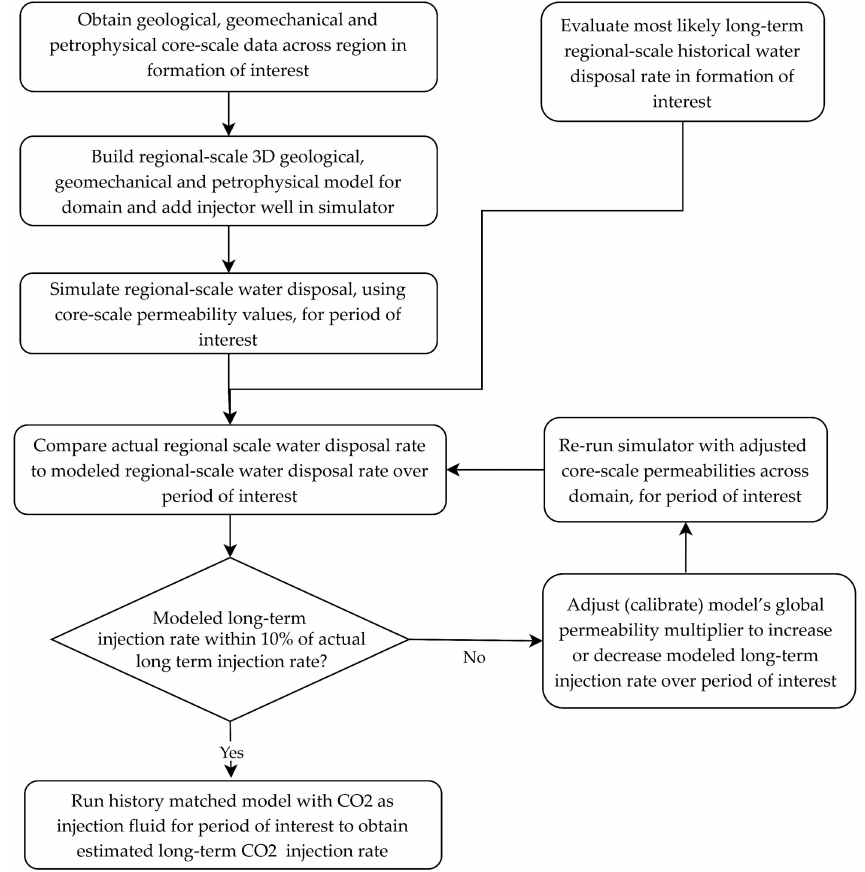
Figure 8. Summary of the workflow used in this study to estimate long-term regional CO 2 injection rates in the Alberta